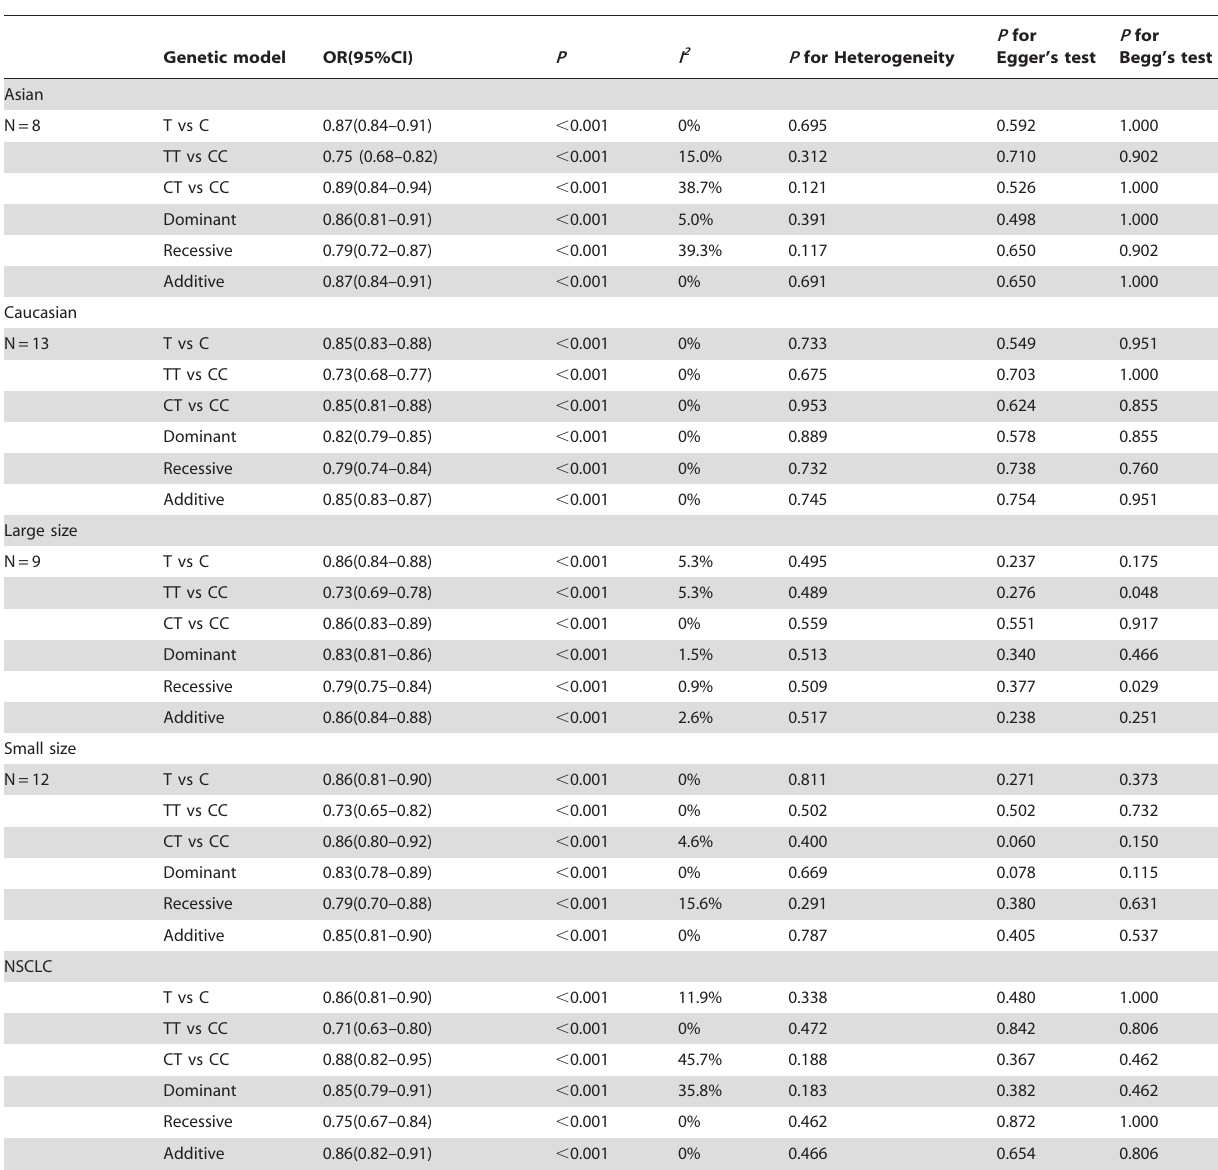
Table 5. Stratified analysis of the association between rs402710 genotype and lung cancer risk.